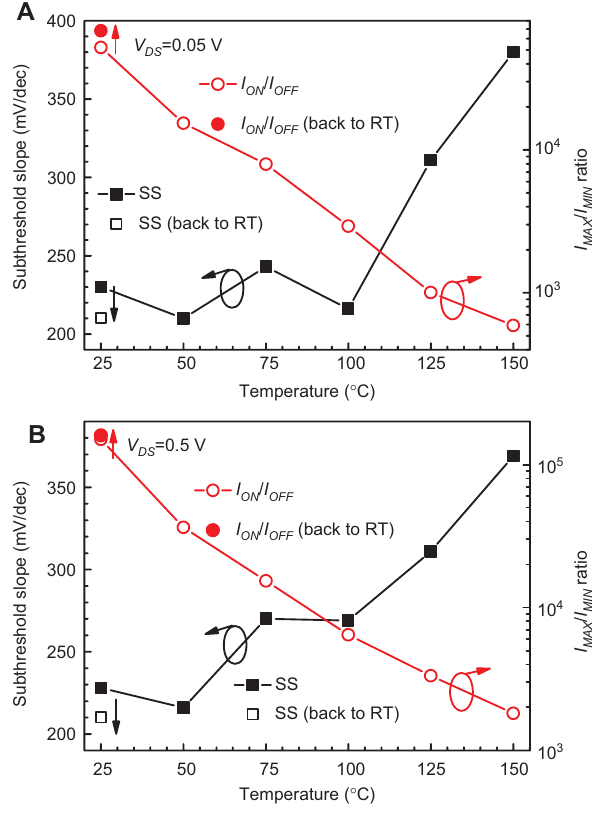
/ I ratio of MAX MIN = 0.05 V and > 75 ° C for DS